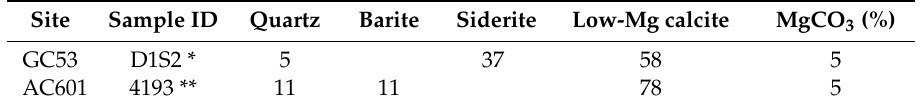
Table 1. Mineral compositions (X-ray di ff raction analyses) of low-magnesium calcite lithologies in % and mol% MgCO 3 in low-Mg calcite (right column) from the Gulf of Mexico.